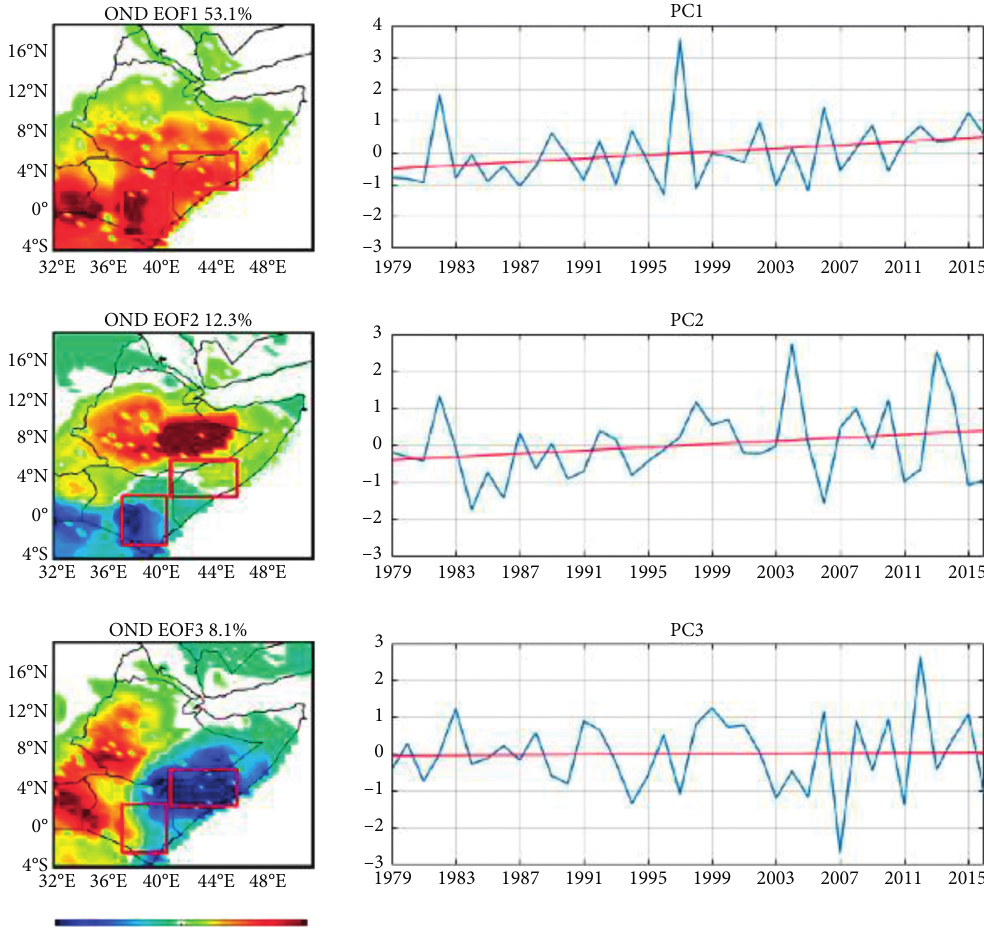
Figure 6: Spatial patterns of the first three EOF of autumn rainfall over the GHA (left panels) and the corresponding principal components: PC1, PC2, and PC3 (right panels), respectively. Red boxes in left panels are the OND